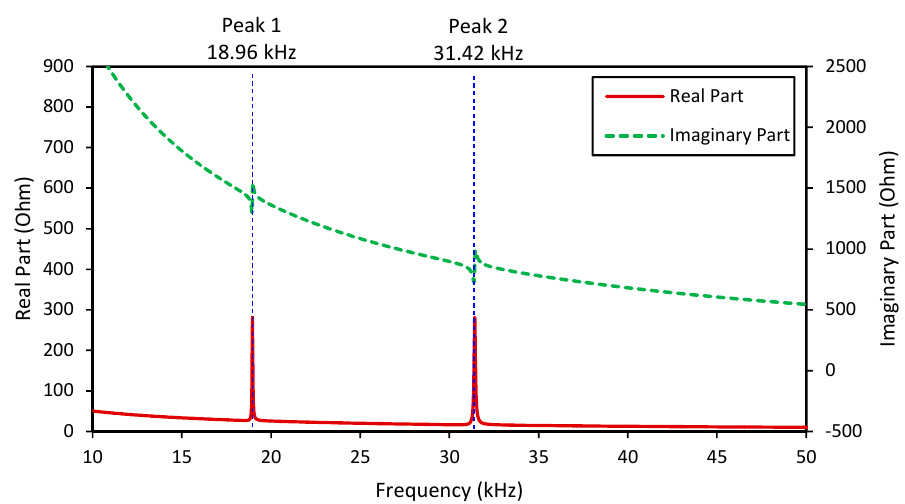
Figure 3. Impedance responses of the impedance model with infinitive contact stiffness ( ξ = k s /k c = 0).